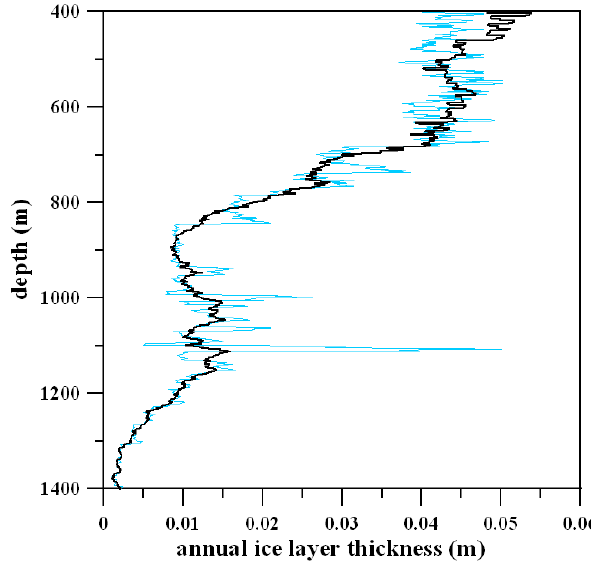
Fig. 3 : Evolution with depth of the annual ice layer thickness along the TALDICE core 1079 Fig. 3. Evolution with depth of the annual ice layer thickness along deduced from a simple interpolation of age between gas stratigraphic markers (blue line) and 1080 the TALDICE core deduced from a simple interpolation of age be- deduced from the inverse method (black line). 1081 tween gas stratigraphic markers (blue line) and deduced from the inverse method (black